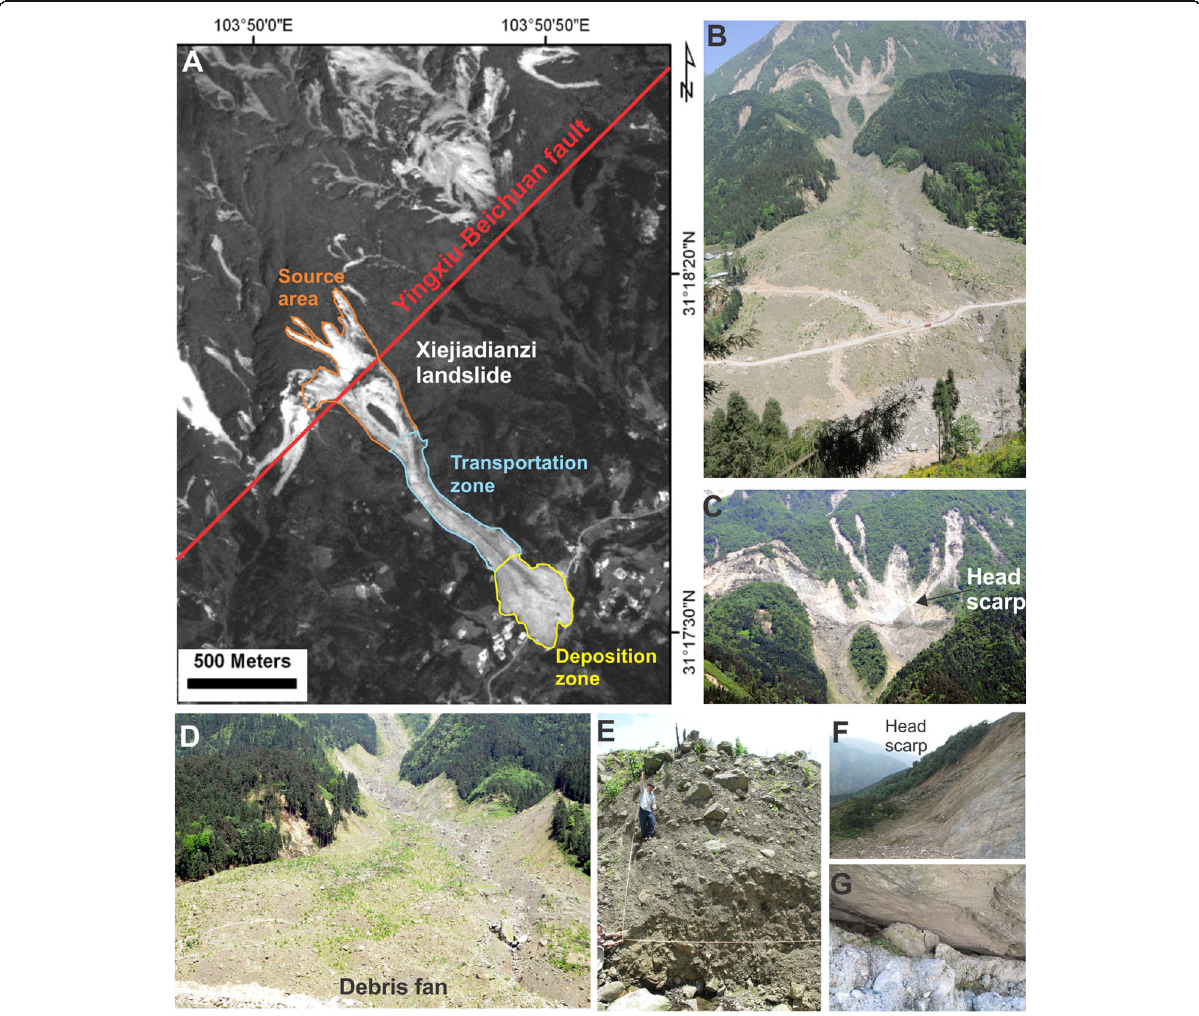
Fig. 9 Xiejiadianzi landslide. a ALOS PRISM Pan image of the Xiejiadianzi landslide; b Overview photo; c Source area; d Depositional zone; e Exposure of the deposits in the debris fan revealed by the valley incision; f Head scarp, and g Fine sediments under and mudline on a large block, indicating possible liquefaction